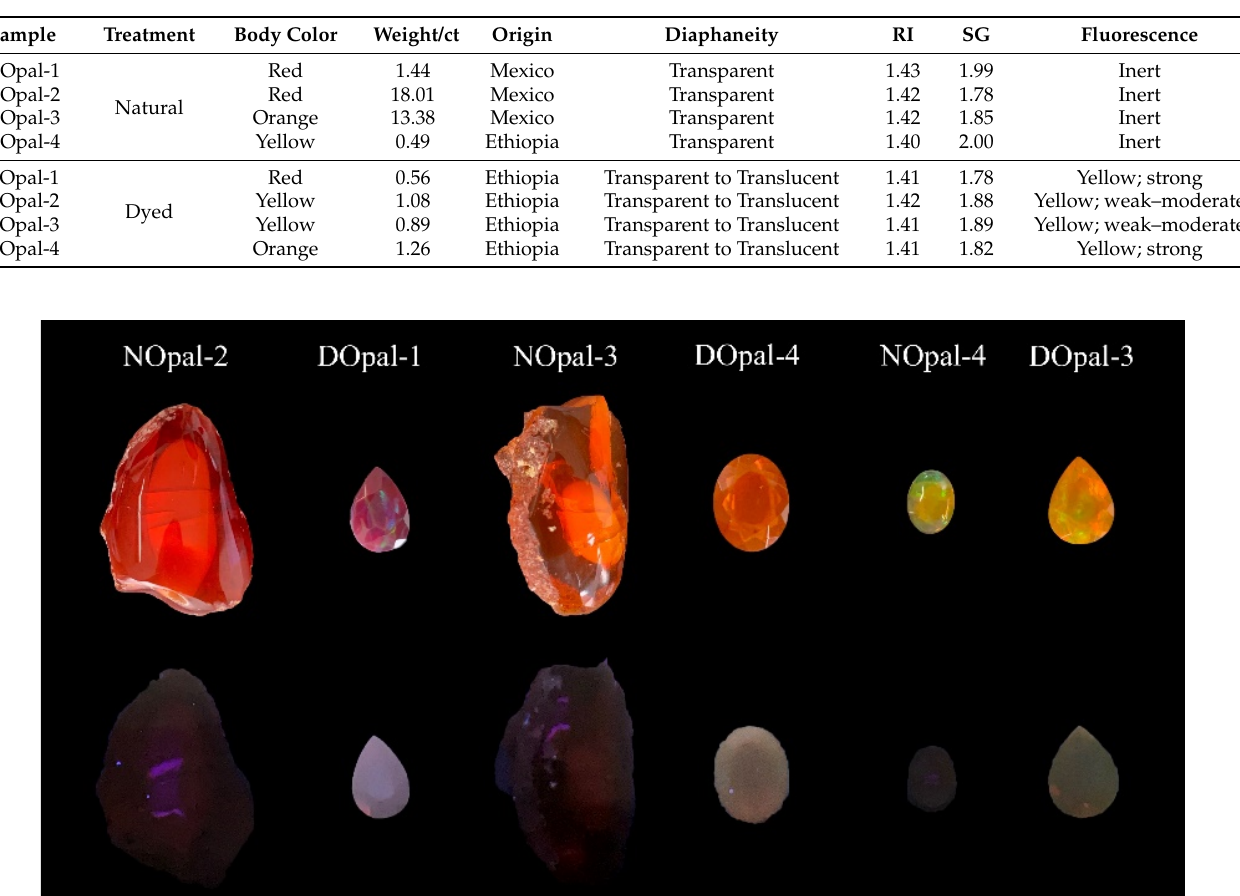
Table 1. Descriptions of gemological properties.